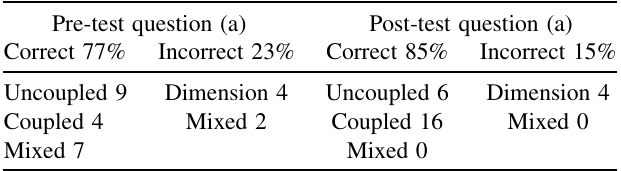
TABLE I. Correctness percentage of 26 students answering question (a) in the pre-test and post-test. The items represent the types of students’ correct or incorrect answers and the corre- sponding numbers stand for the number of students giving a par- ticular type of answer. The item ‘‘mixed’’ means that the students expressed the coupled singlet and triplet states using the uncoupled basisvectors. The item ‘‘dimension’’represents the mistakes related to the dimension of the Hilbert space, e.g., only writing down the basis vectors in the subspace of one of the spins.